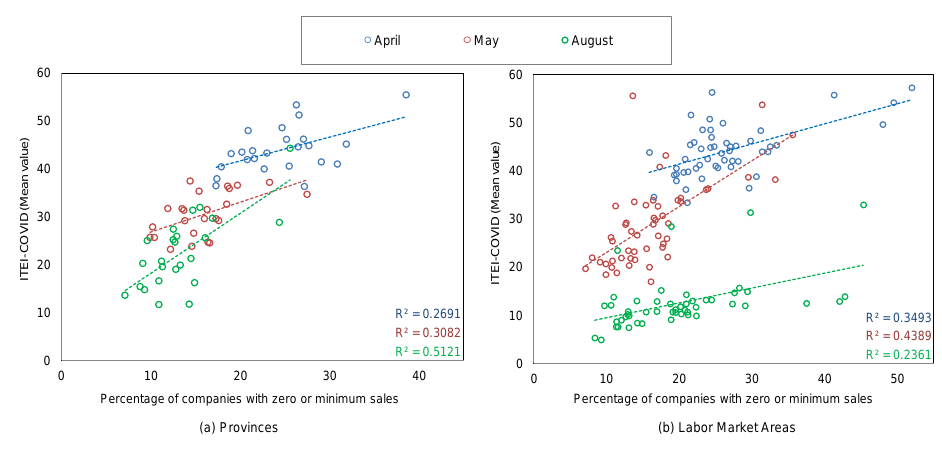
Figure 6: ITEI values versus the percentage of companies in a critical situation